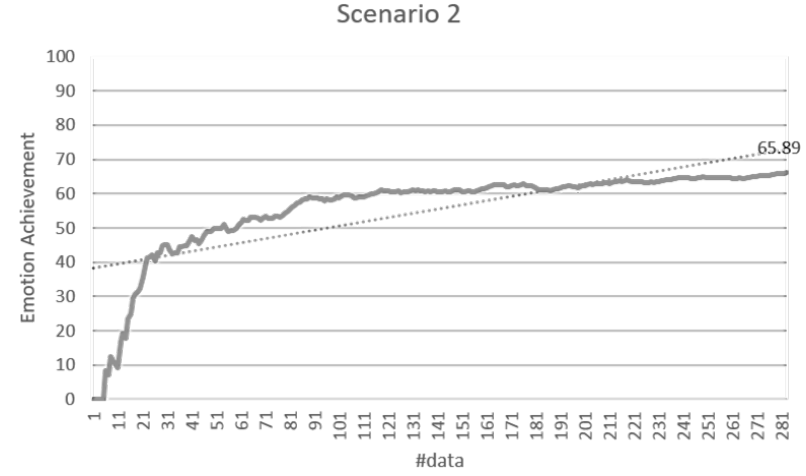
Figure 16. Emotion achievement for scenario 2. The thick line shows the increase of the achievement according to the number of sensory changes, and the dotted line shows the trend of this increase.